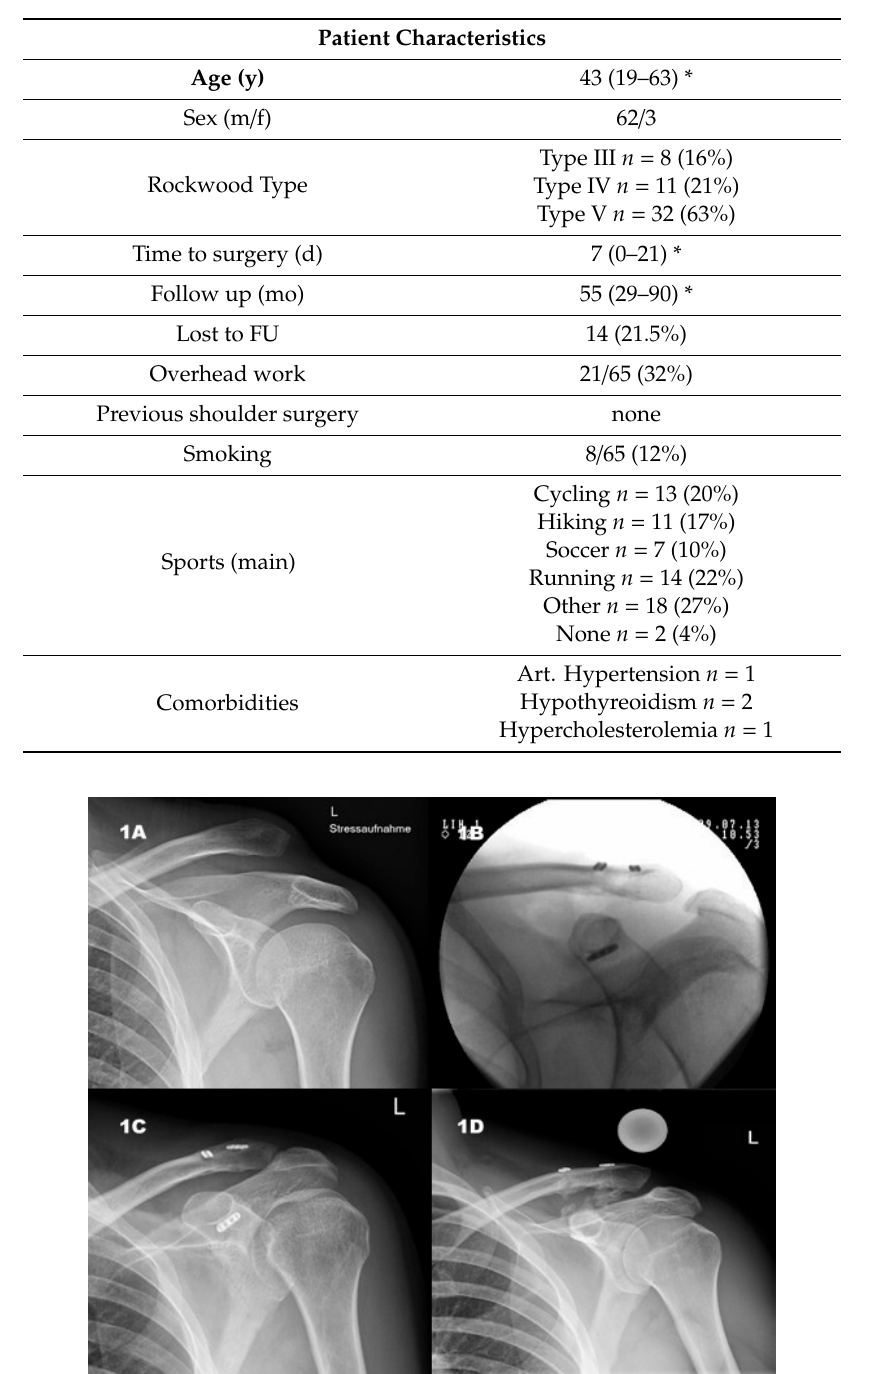
Table 1. Patient characteristics. Y = years, m = male, f = female, d = days, mo = months; * Data reported as median (range).